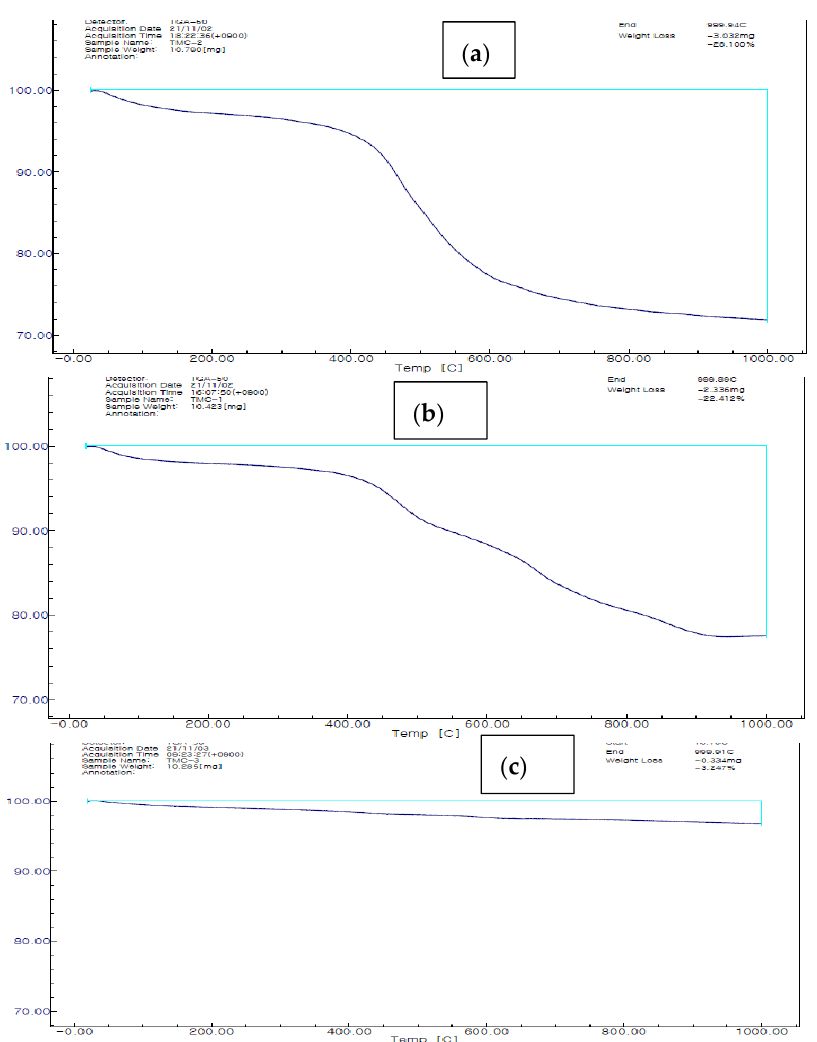
Figure 7. ( a – c ) Thermogravimetric analysis plot for the unmodified montmorillonite, doped titanium nanocomposite and the tripartite magnetic montmorillonite.